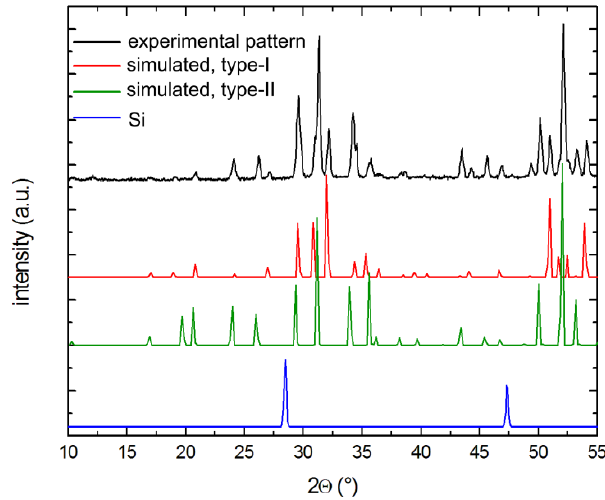
Figure 5. Representative powder x-ray pattern of a Cs-containing sample after soaking in 1 M NaOH solution. Both clathrates types are detected, while Si is dissolved